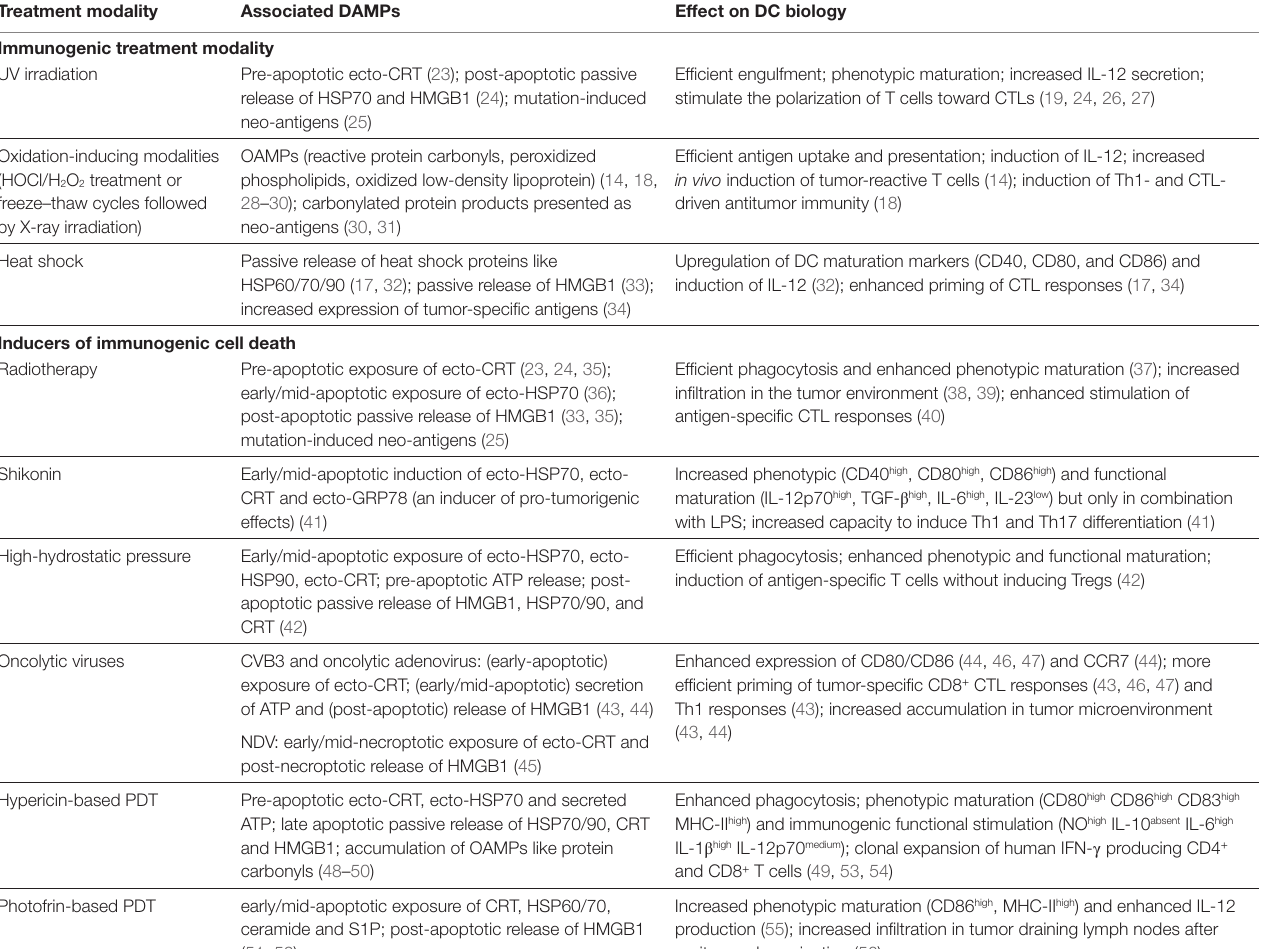
TABLe 1 | A list of prominent enhancers of immunogenicity and iCD inducers applied in DC vaccine setups and their associations with DAMPs and DC biology. Treatment